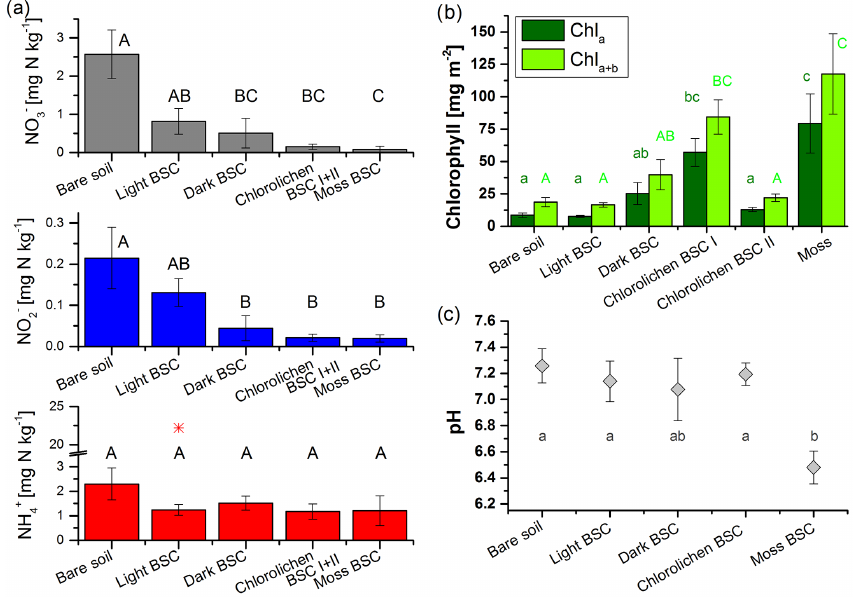
Figure 3. Nutrient and chlorophyll contents as well as pH values of bare soil and biocrust samples of different types. (a) Nitrate, nitrite and ammonium content of all replicates. The red star indicates an outlier; (b) chlorophyll a and chlorophyll a + b contents of samples after flux measurements and (c) pH values of samples without and after flux measurements (bare soil and moss BSC: n = 4; light, dark and chlorolichen BSC: n = 3). For the number of replicates for a and b , see Table 1. In all three plots error bars indicate standard error of the mean and different letters indicate significant differences (of log-transformed data; p =